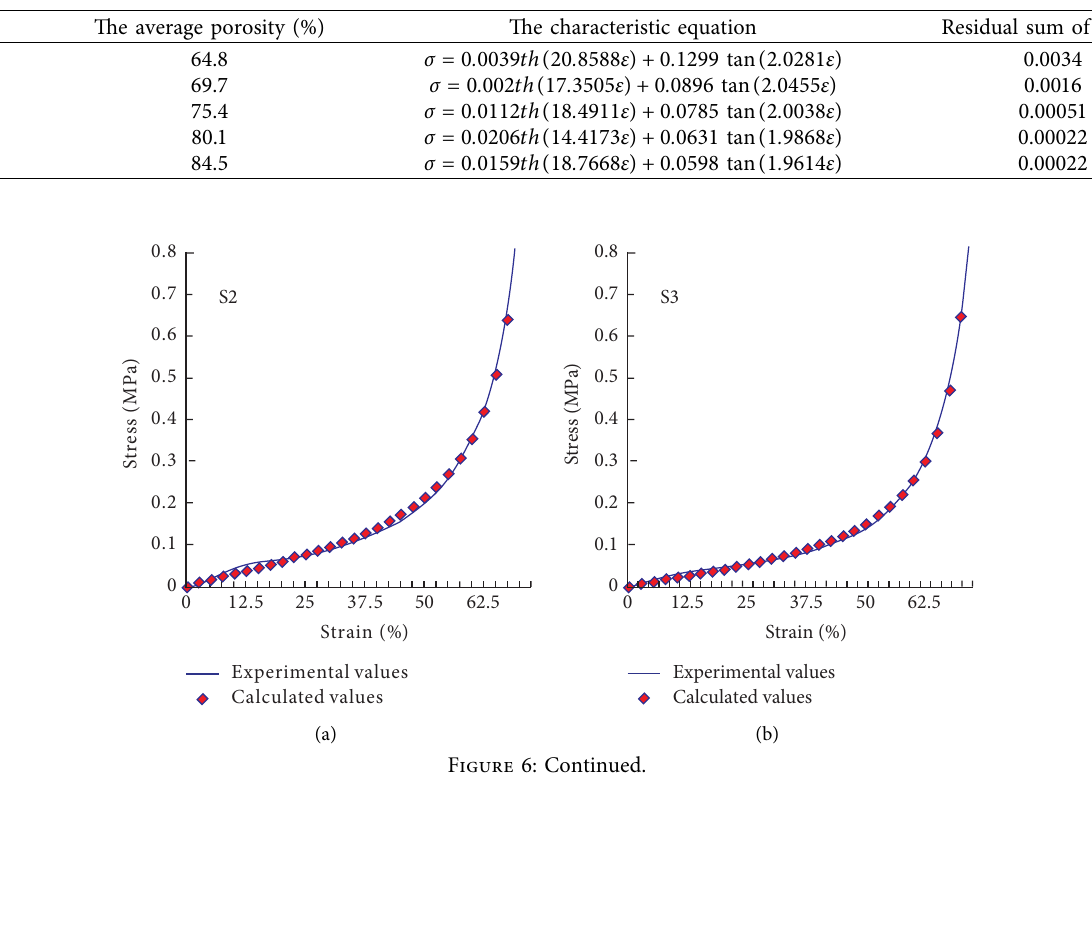
Figure 5: Comparison of the stress-strain curves of the experimental values and calculated value. Table 2: Static compression characteristic equation of different porosity samples.